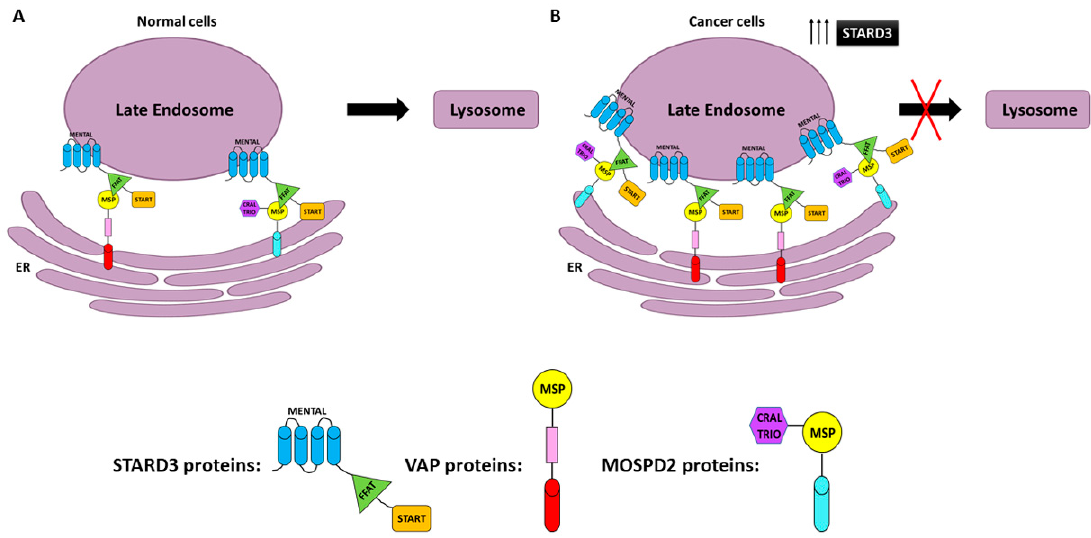
Figure 3. Endoplasmic reticulum–endosome interaction in normal (ER–LE) ( A ) and cancer cells overexpressing STARD3 ( B ). The STARD3/START domain interacts with vesicle-associated membrane-protein-associated proteins (VAP) or motile sperm domain-containing protein 2 (MOSPD2) to form ER–LE. FFAT (two phenylalanines in an acidic tract), MENTAL (MLN64 NH (2)-terminal domain), MSP (major sperm protein domain), and CRAL-TRIO (amino-terminal domain).